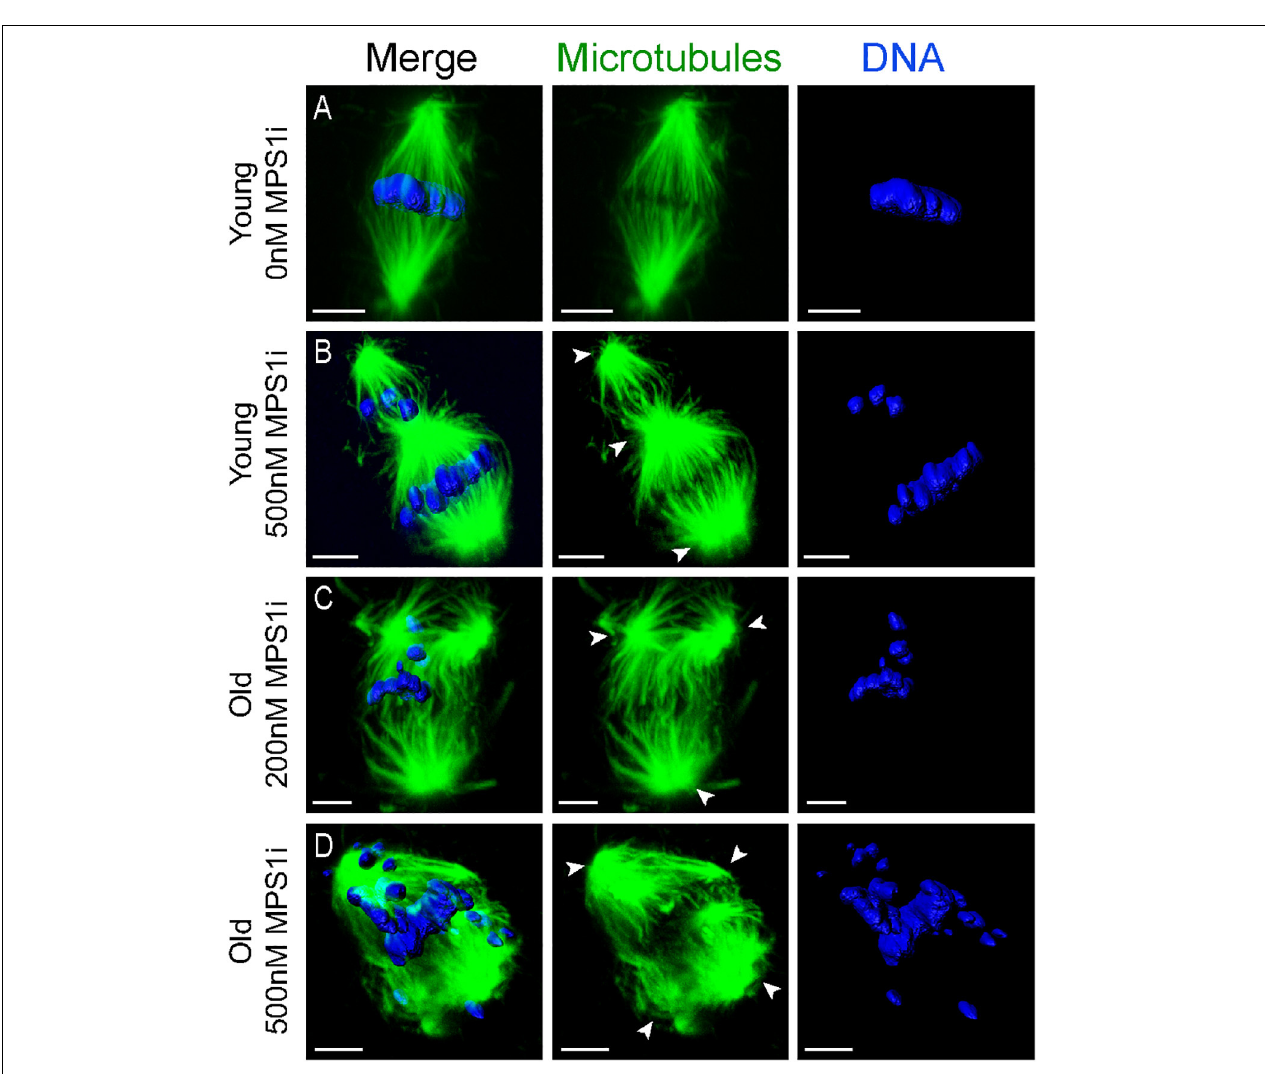
FIGURE 3 | Representative images of spindles of horse MII oocytes treated with MPS1i after Nocodazole washout. Maximum intensity projections of confocal sections. Microtubules (alpha-tubulin, green); chromatin (Hoechst, blue). Scale bars, 5 µ m. (A) Bipolar spindle from a young mare’s oocyte treated with 0 nM of MPS1i; (B) tripolar spindle from a young mare’s oocyte treated with 500 nM of MPS1i; (C) tripolar spindle from an old mare’s oocyte treated with 200 nM of MPS1i; (D) tetrapolar spindle from an old mare’s oocyte treated with 500 nM of MPS1i. Arrowheads indicate the spindle poles.